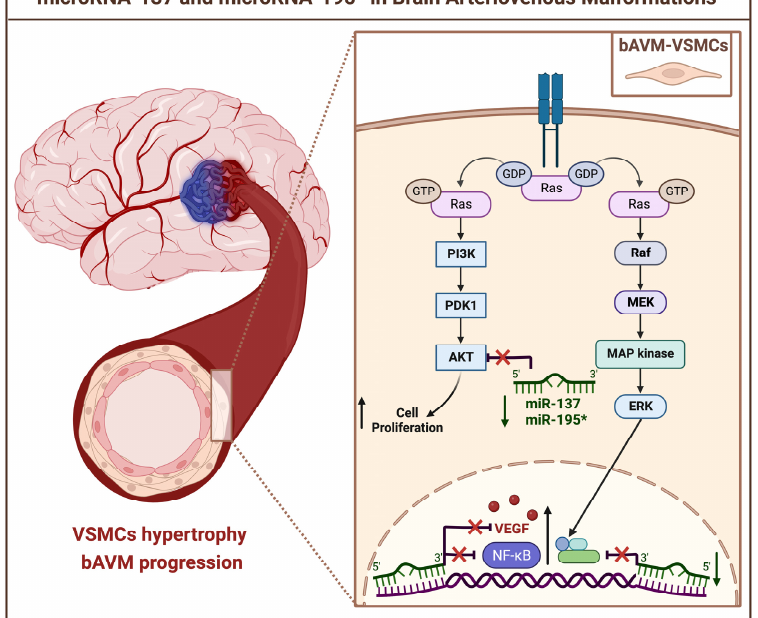
Figure 3. Schematic representation of the microRNA-18a in the pathogenesis of brain AVMs. In the bAVM-derived endothelial cells (bAVM-ECs), the downregulation of miRNA-18a (miR-18a) directly induces an increase in vascular endothelial growth factors (VEGF) transcription, which leads to intense aberrant angiogenesis. The simultaneous repression of thrombospondin-1 (TSP-1) lowers the inhibition of hypoxia-inducible factor 1 α (HIF-1 α ), bone morphogenetic protein 4 (BMP4), plasminogen activator inhibitor-1 (PAI-1), DNA-binding protein 1 (Id-1), matrix metalloproteinases (MMP2 and 9), and ADAM metallopeptidase domain 10 (ADAM10); all involved in vascular proliferation and rearrangement. basis for the genetic analysis of the cross-link between VSMCs, biomolecular growth sig- nals, and inflammation pathways [37].